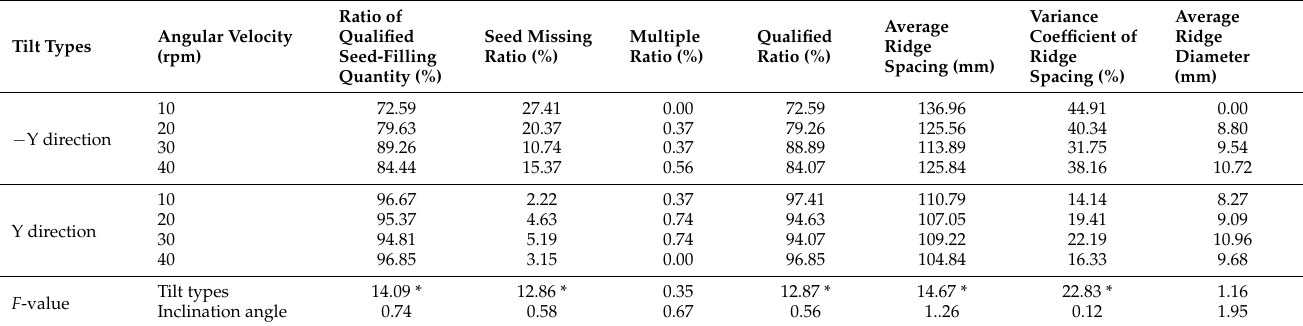
Table 4. Seeding performance under various angular velocities ( θ = 6 ◦